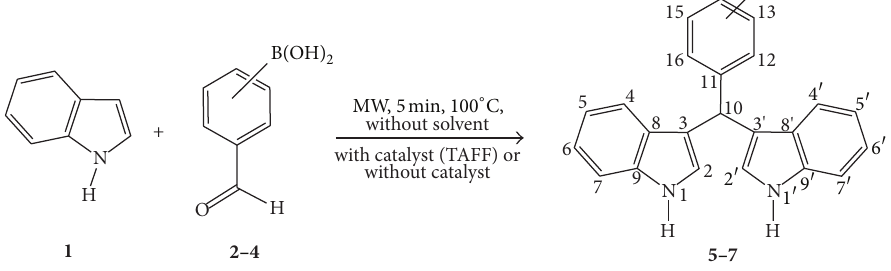
Scheme 2: Production of